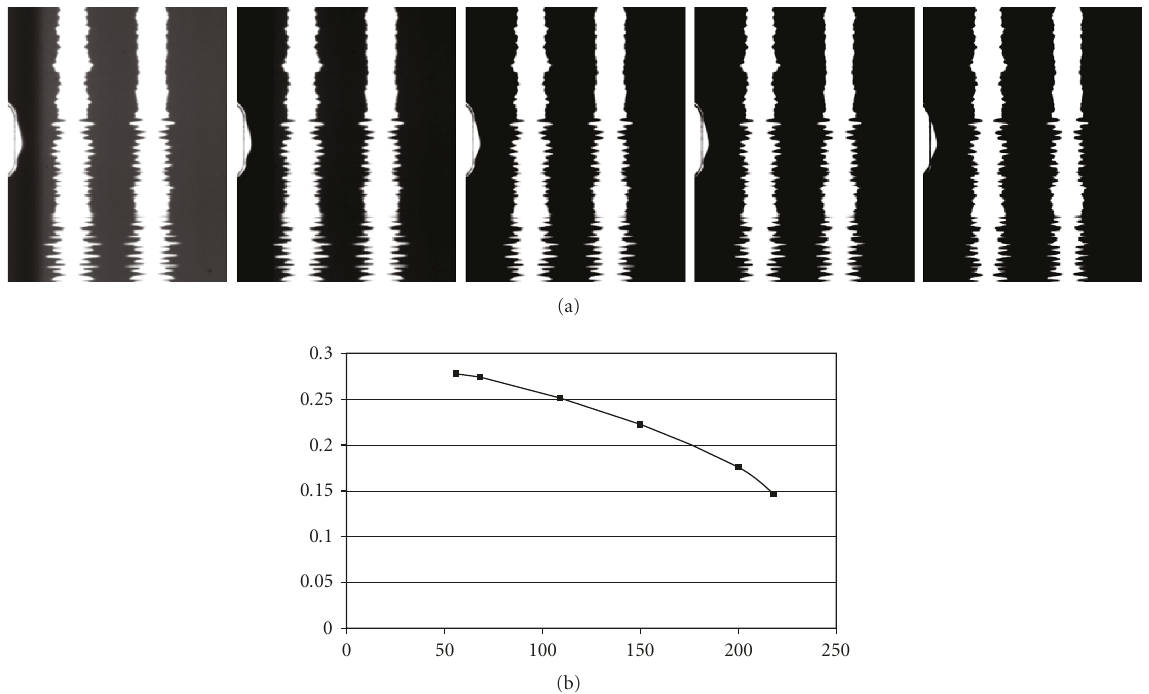
Figure 23: Optical representation of ca. 1/75 second of stereo soundtrack. From left to right: as grabbed, histogram stretching at first iteration (based on histogram), 2nd, 3th, and 4th iteration. Below: plot of the HD indicator value versus p min . The HD indicator values for this plot is the mean value computed on 64000 samples (1,33